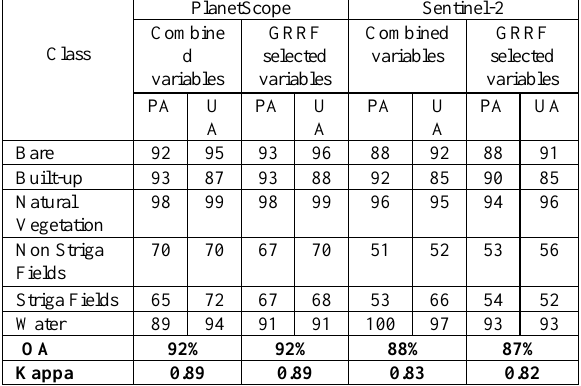
Table 3: Summarized confusion matrices and classification accuracies, Overall accuracy (OA), Producer’s Accuracy (PA) User’s Accuracy (UA) and Kappa statistics using the Guided Regularised Random Forest image classification of PS and S2 comparing combined variables (all bands and all indices) and GRRF selected variables (fewer optimum bands and indices selected with the Guided Regularised Random Forest algorithm.